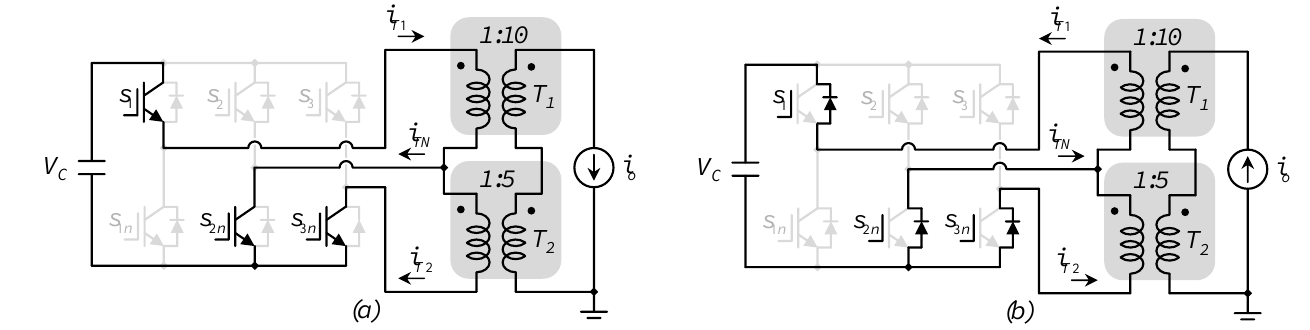
Figure 13. Current flow for different directions of the load current when s 1 = 1, s 2 = 0, and s 3 = 0. ( a ) when the load current is positive and ( b ) when the load current is negative.